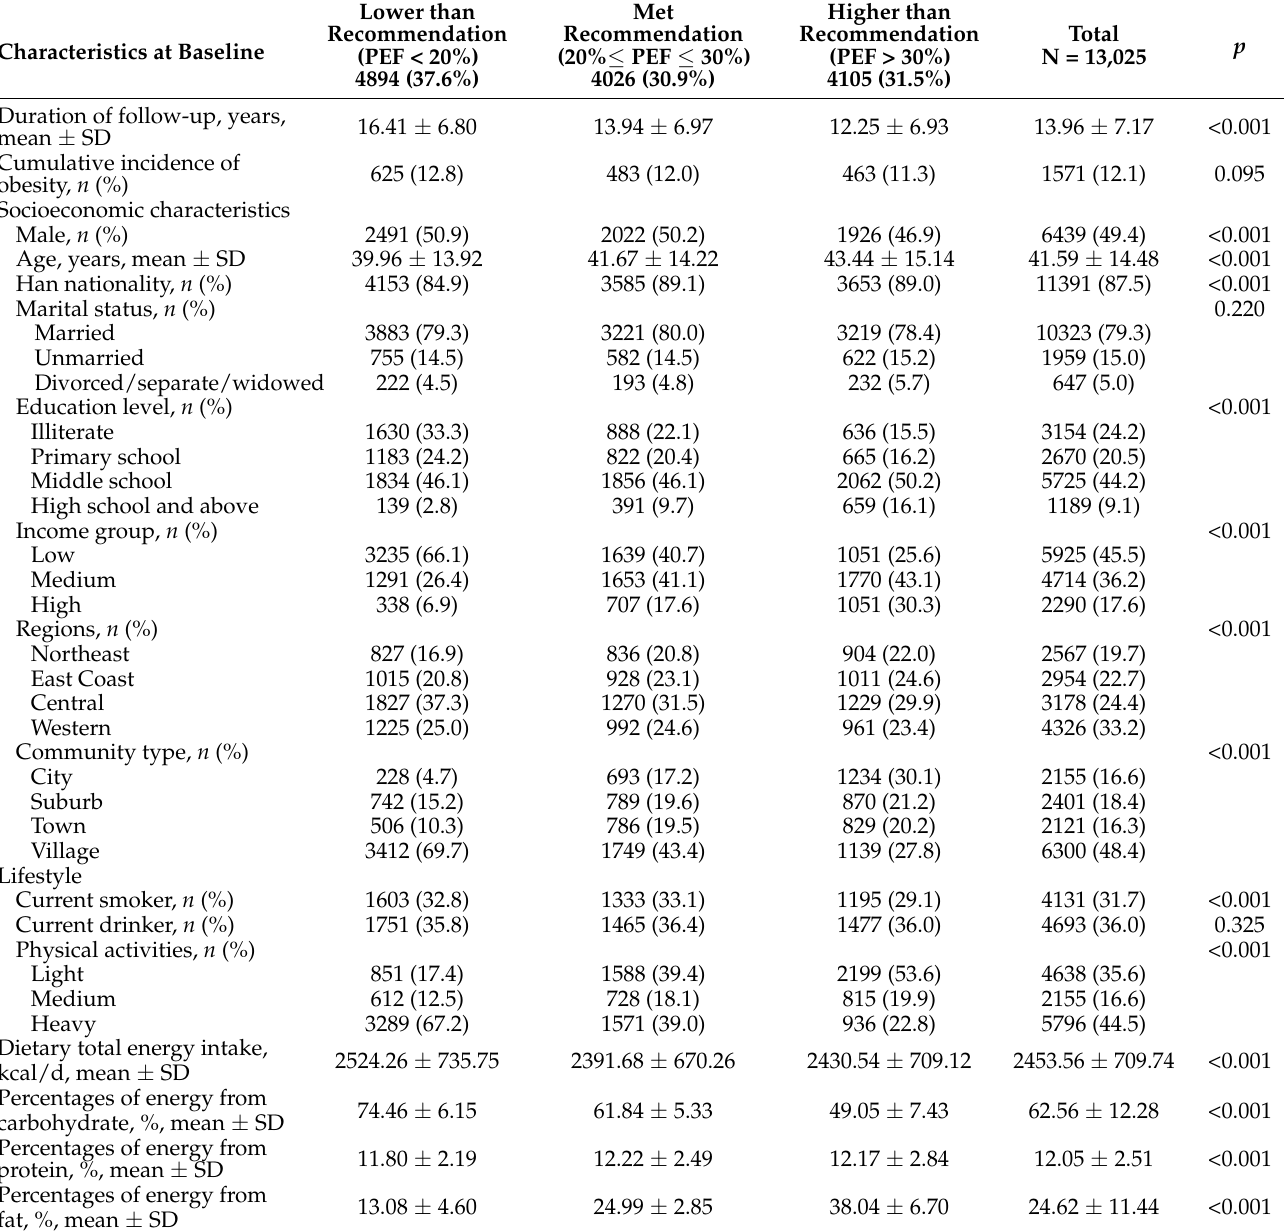
Table 1. General characteristics of participants by percentage of energy from fat at